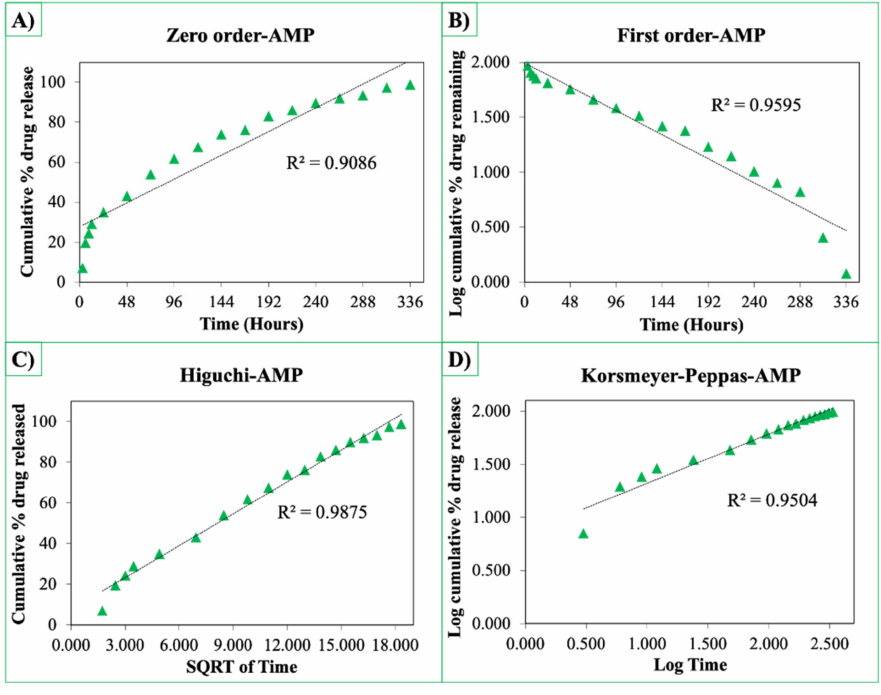
Figure 10. Zero order ( A ), first order ( B ), Higuchi ( C ), Korsmeyer–Peppas ( D ) kinetic releases of BC/PCL+AMP patch.